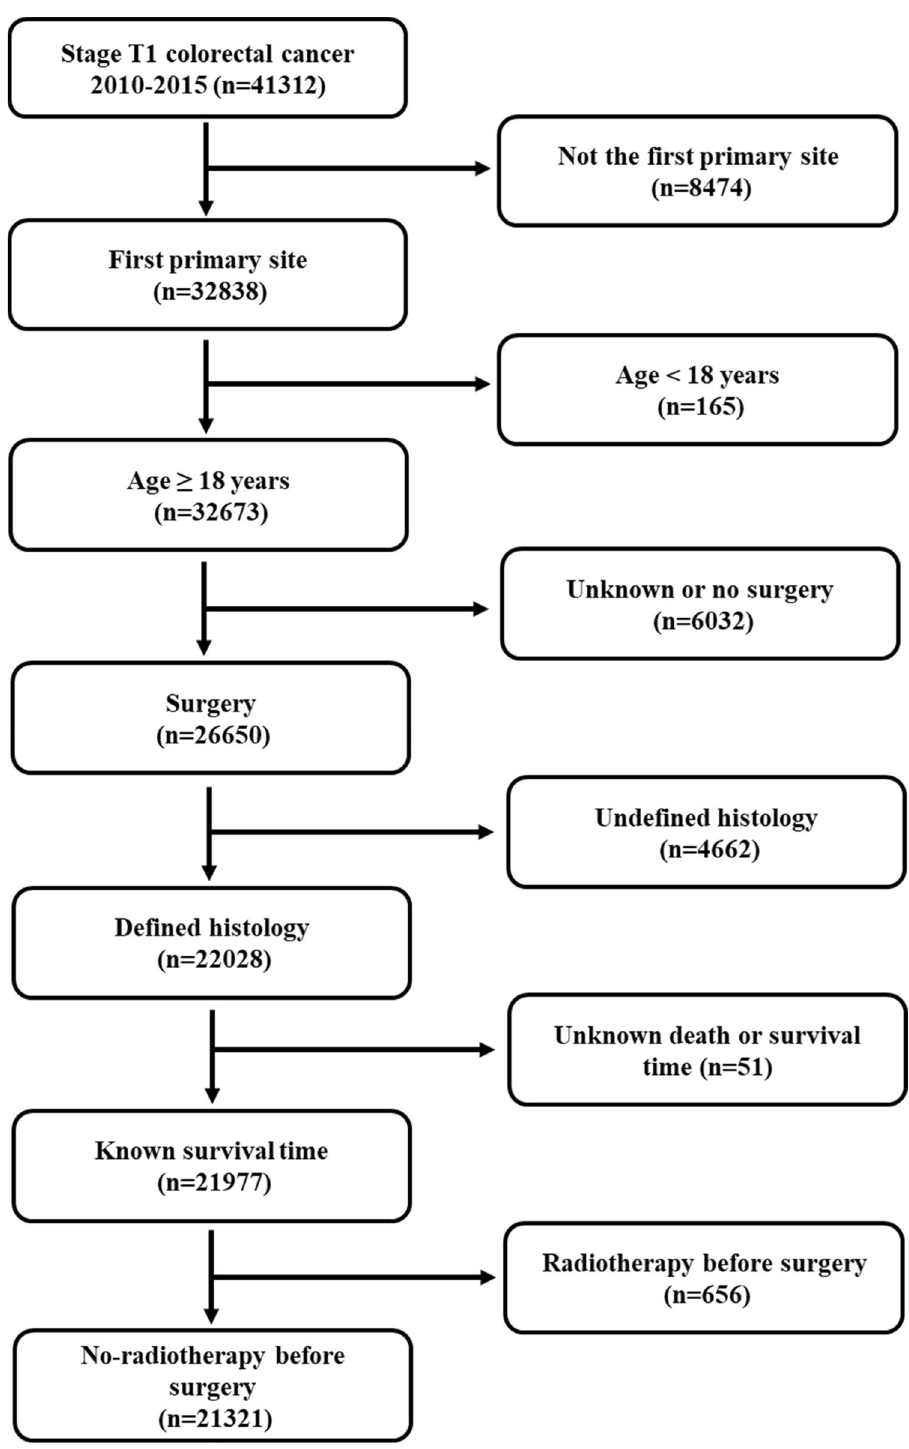
Figure 3. Flowchart of data selection based on inclusion and exclusion